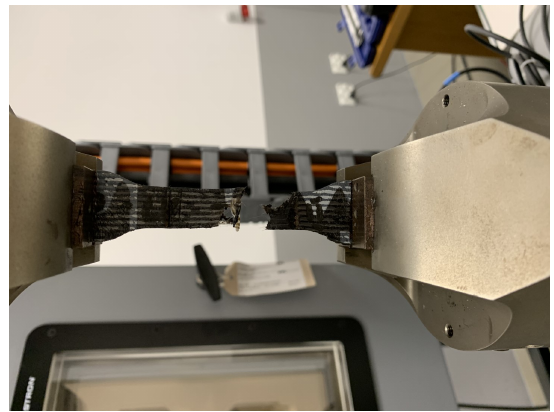
Figure 4. Sample after the testing